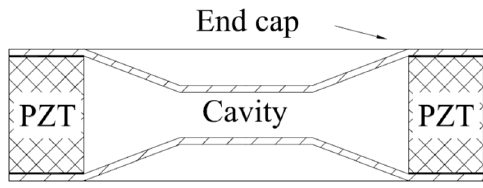
Figure 21. Structure with concave end cap.